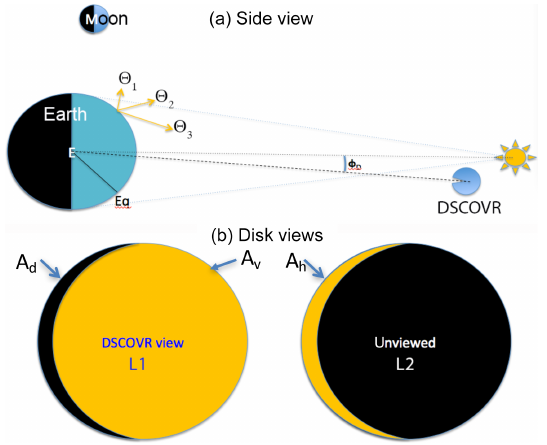
Figure 1. Schematic of the (a) Earth–Sun–DSCOVR geometry and (b) Earth disk visible to the L1 DSCOVR view (left with an area fraction of A t ) and to the L2 view (right). The golden area on the left shows the daytime area fraction ( A v ) visible to DSCOVR, the black area on the left shows the night portion ( A d ) within the DSCOVR view, and the golden area on the right is the daytime portion ( A h ) missed by DSCOVR. Not to